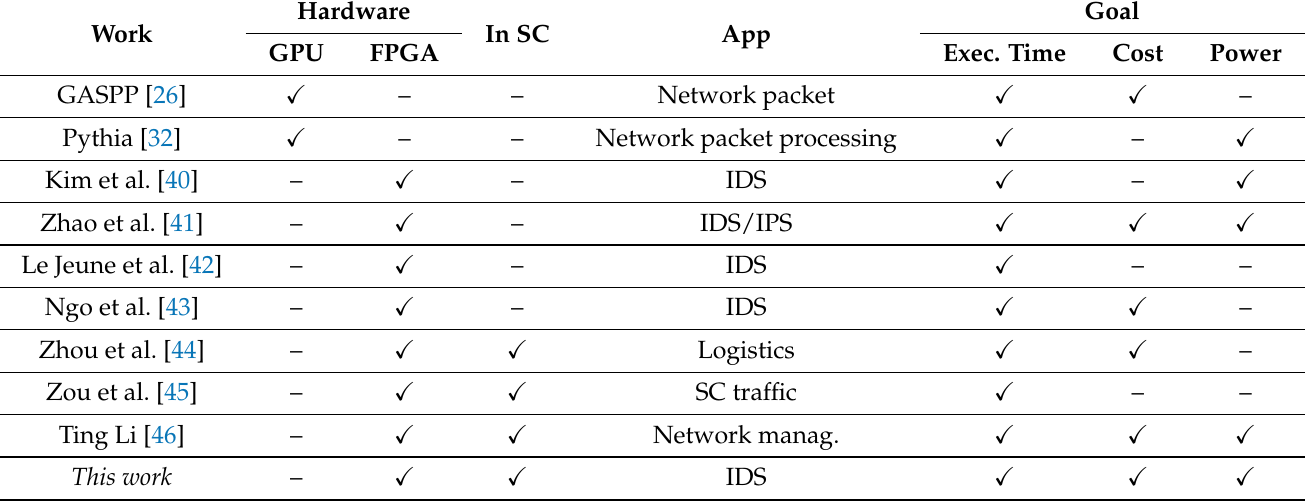
Table 1. Comparison of recent and closely related